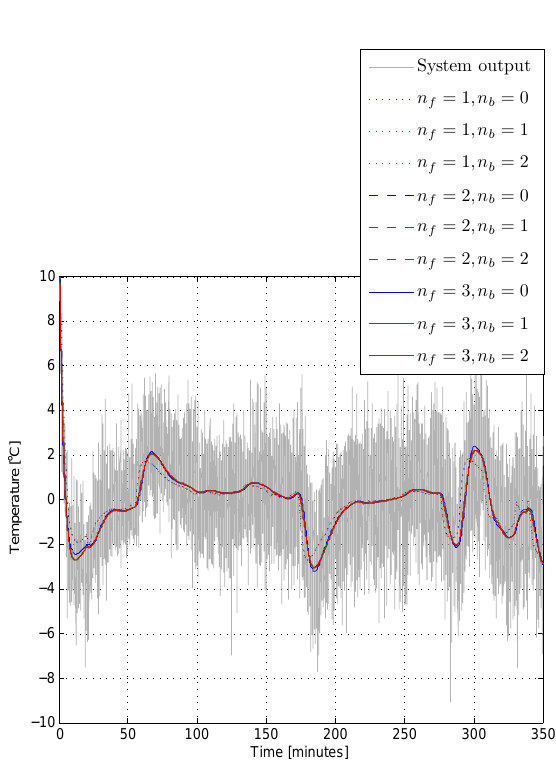
Figure 12: Polynomial OE models with all combina- tions of n b The time delay is n d = 0 for all models.